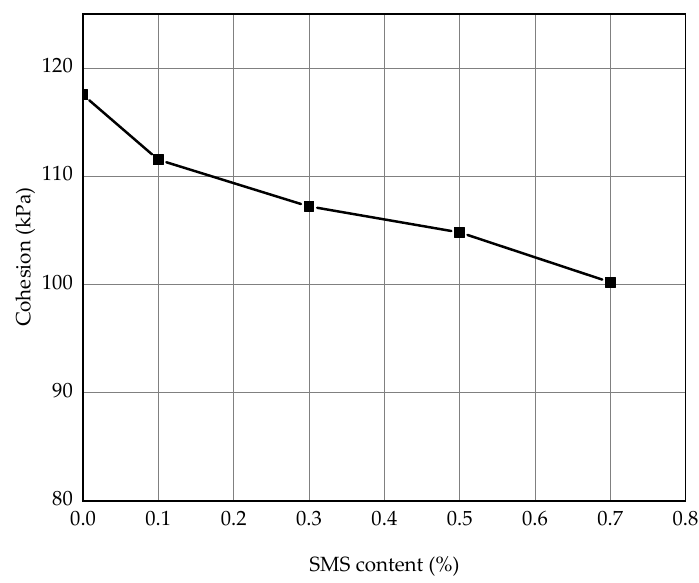
Figure 4. Change of cohesion force with SMS content.